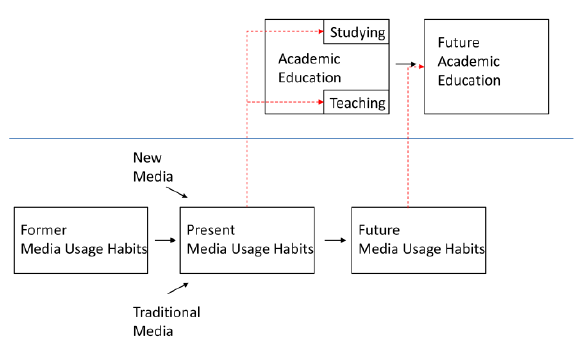
Figure 1. Framework of the media usage